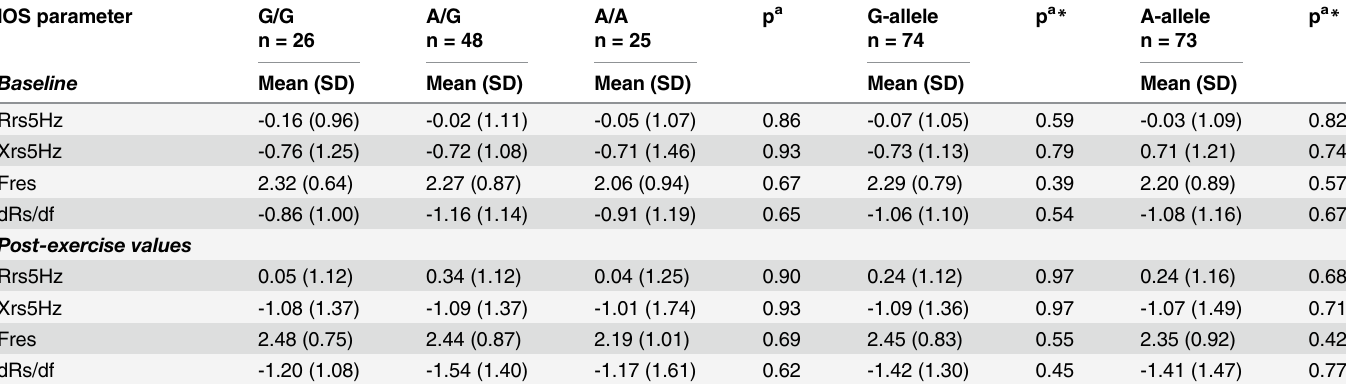
Table 2. Impulse oscillometry presented as Z-scores in relation to IL-10 rs1800896 polymorphism in 99 children under the age of seven after hospi- talisation for bronchiolitis at less than six months of age. IOS